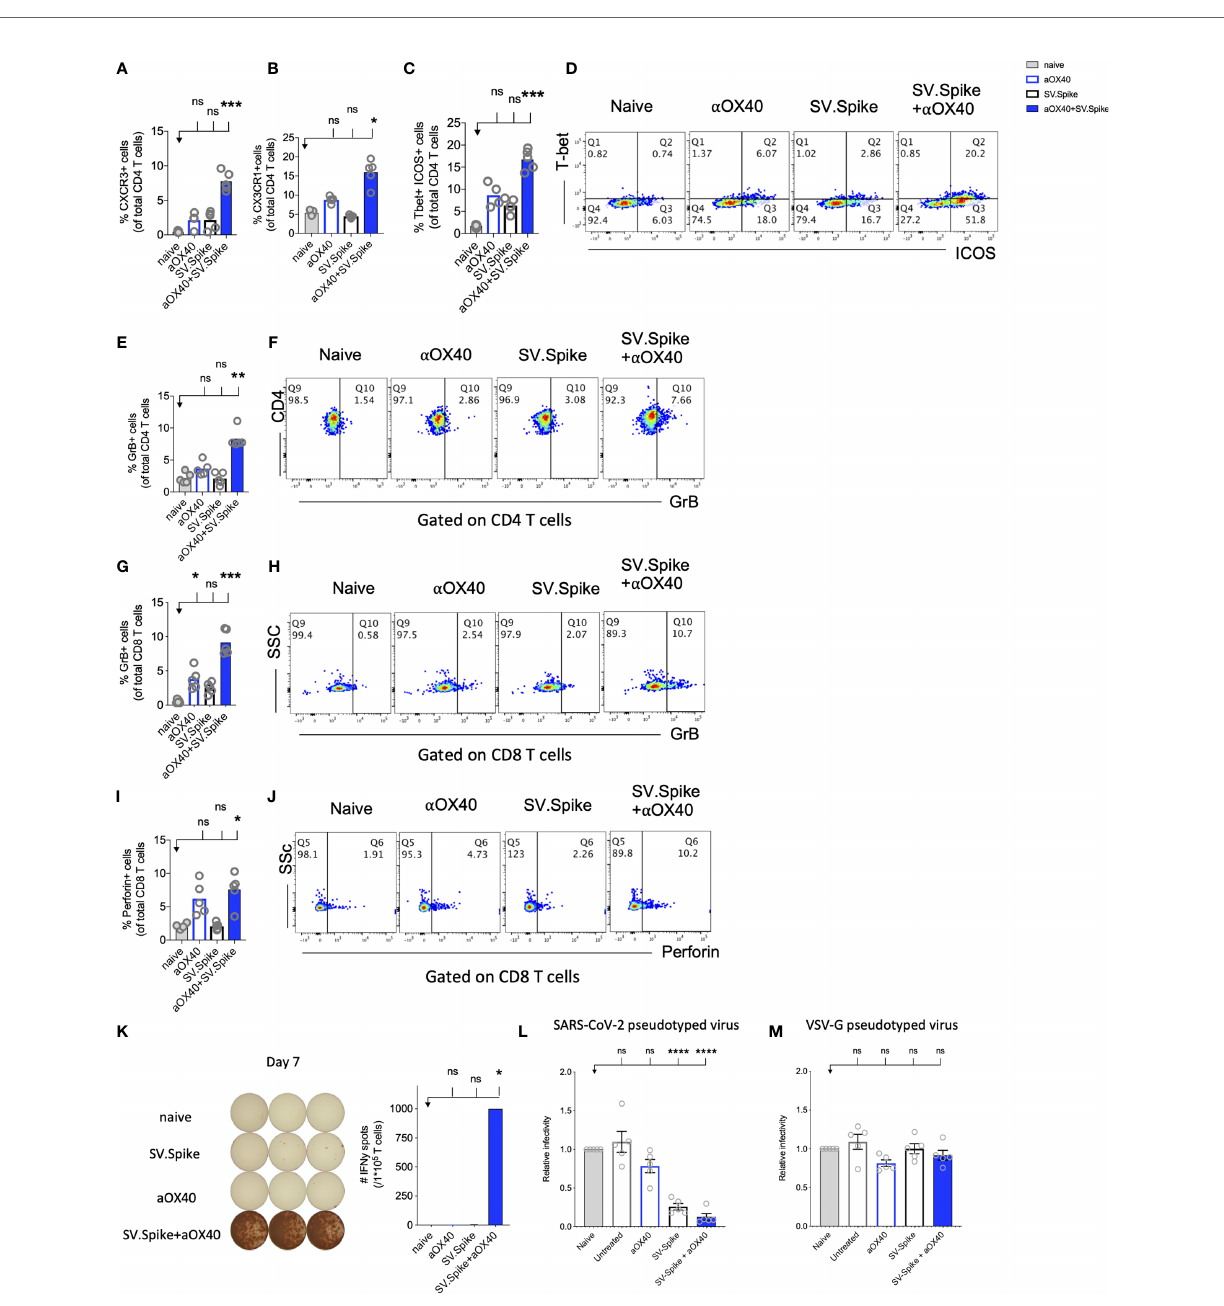
FIGURE 7 | Reprogrammed T cells in SV.Spike+ a OX40 vaccinated mice display enhanced Th-1 T-cell phenotype mediated cytokine production and cytotoxic T-cell activity. Spleens of C57BL/6J naïve and vaccinated mice were excised on day 7 after prime vaccine doses for fl ow cytometry analysis (A – J) . T cells were further isolated for (K) Interferon-g (IFN g ) enzyme-linked immunospot analysis (ELISpot) and (L, M) cytotoxicity analysis. Percentage of (A) CXCR3 and (B) CX3CR1 expressing CD4+ T cells indicating Th1-like T-cell effector phenotype. (C) Percentage of Tbet+ICOS+ positive Tfh-like effector CD4+ T-cell polarization. (D) Representative blots. (E) Percentage of granzyme B (GrB) positive CD4+ T cells from indicated groups using fl ow cytometry. (F) Representative blots. (G) Percentage of GrB positive CD8+ T cells from indicated groups using fl ow cytometry. (H) Representative blots. (I) Percentage of Perforin positive CD8+ T cells. (J) Representative blots. Bars represent means ± SEM (A – J) and each symbol represent an individual mouse (n=5 per group). Statistical signi fi cance was determined with the Kruskal-Wallis test followed by Dunns ’ test. Results are representatives of at least two independent experiments. (K) Amount of IFN g spots per 10 5 T cells determined by ELISpot. (L, M) Cytotoxic activity of T cells harvested on day 7 from control and treated mice (n = 5 mice per group). T-cells were isolated from splenocytes and were co-cultured with 293T/ACE2 cells for 2 days. Effector-to-target (E/T) cell ratio (T cells/ACE2 cells) was 30:1. Cytotoxicity was determined for each group of mice by measuring the infectivity of luciferase-encoding pseudotyped particles with (L) Spike protein of SARS-CoV-2 or (M) VSV-G and is shown relative to naive T cells. Bars or symbols represent means ± SEM, and statistical signi fi cance was determined with one-way ANOVA with the Bonferroni correction. n.s. > 0.05, *p<0.05, **p<0.01, ***p ≤ 0.001, ****p ≤